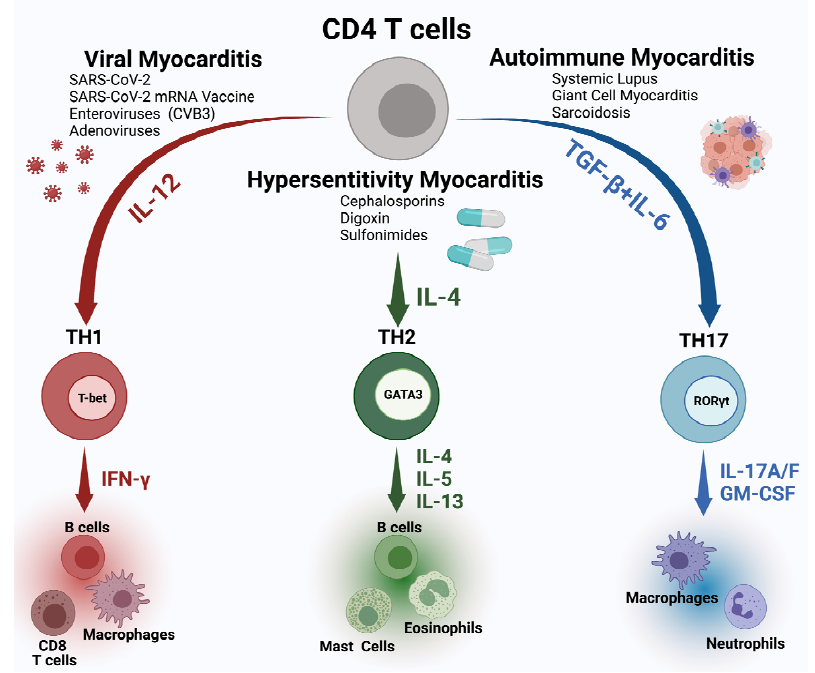
Figure 1. T helper cell pathways leading to three subtypes of myocarditis. Viral myocardi- tis activating Th1 pathway driven by IL-12 induces IFN γ production and CD8 + T cells as the main effector cells. Hypersensitivity myocarditis is induced by Th2 pathway driven by cytokines (IL-4, IL5, and IL13), mast cells, eosinophils, and B cells. Autoimmune myocarditis is driven by the Th17 pathway, with the IL17A/ F, and GM-CSF as the main cytokines inducing neutrophil and inflammatory monocyte responses.